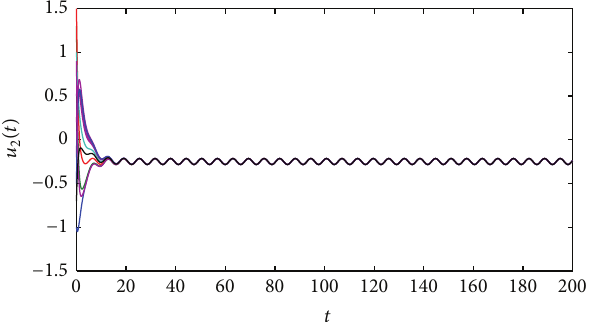
Figure 2: Transient response of state variables 𝑢 2 (𝑡) of Example 1.